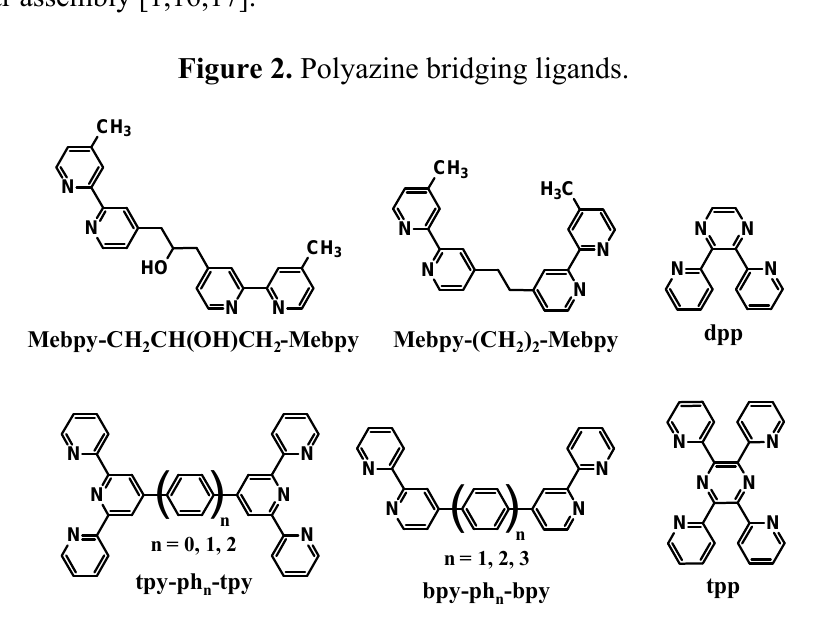
Figure 3. Schematic representation of ED-BL-EA orbital energetics showing excitation followed by intramolecular electron transfer. ED = electron donor, BL = bridging